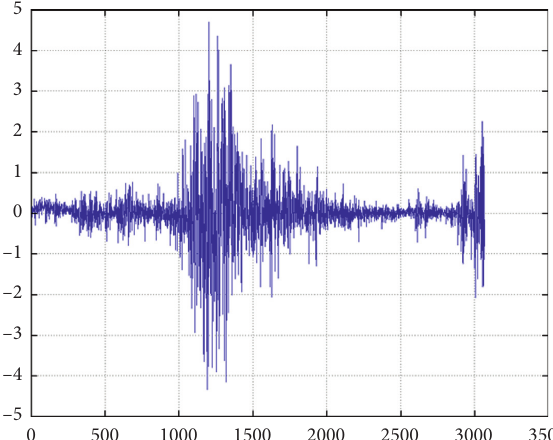
Figure 7: Elman residual plot under E 1.